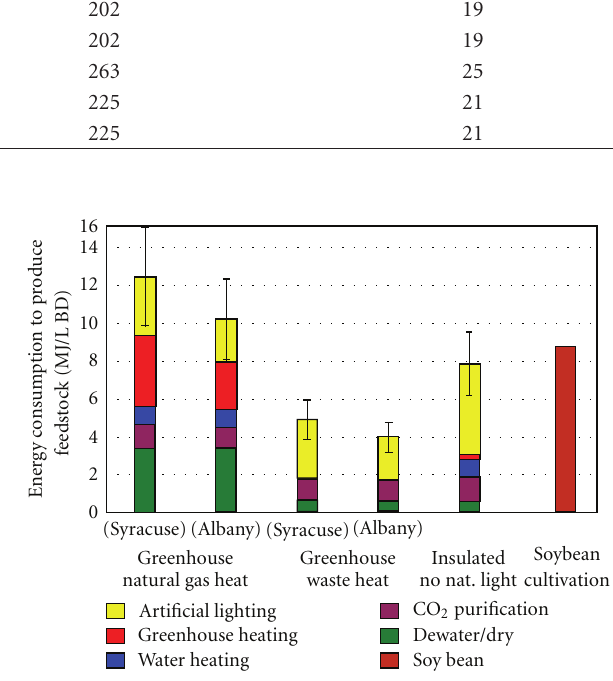
Figure 5: Algae Biomass production for Syracuse and Albany, NY, with natural lighting supplemented by artificial lighting for continuous algae production.